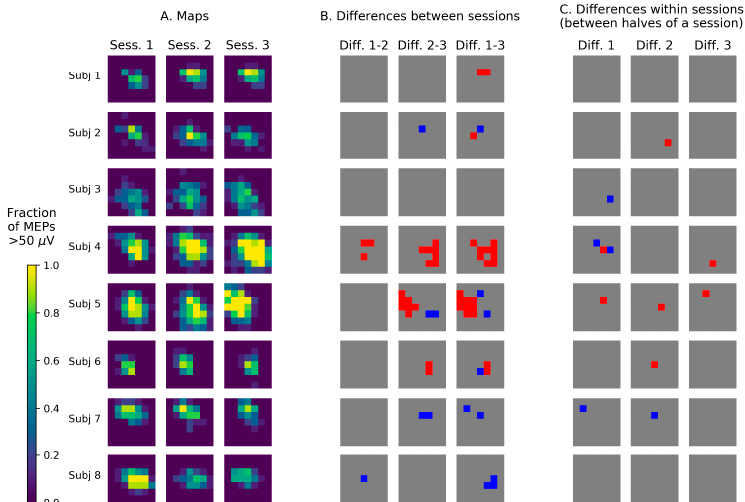
Figure 2. ( A ) TMS maps of the APB muscle from three sessions performed on consecutive days. The squares represent the stimulation grid cells, and the color encodes the fraction of the applied 10 stimuli that produced suprathreshold MEPs (above 50 μ V). ( B ) Results of the comparison of the first